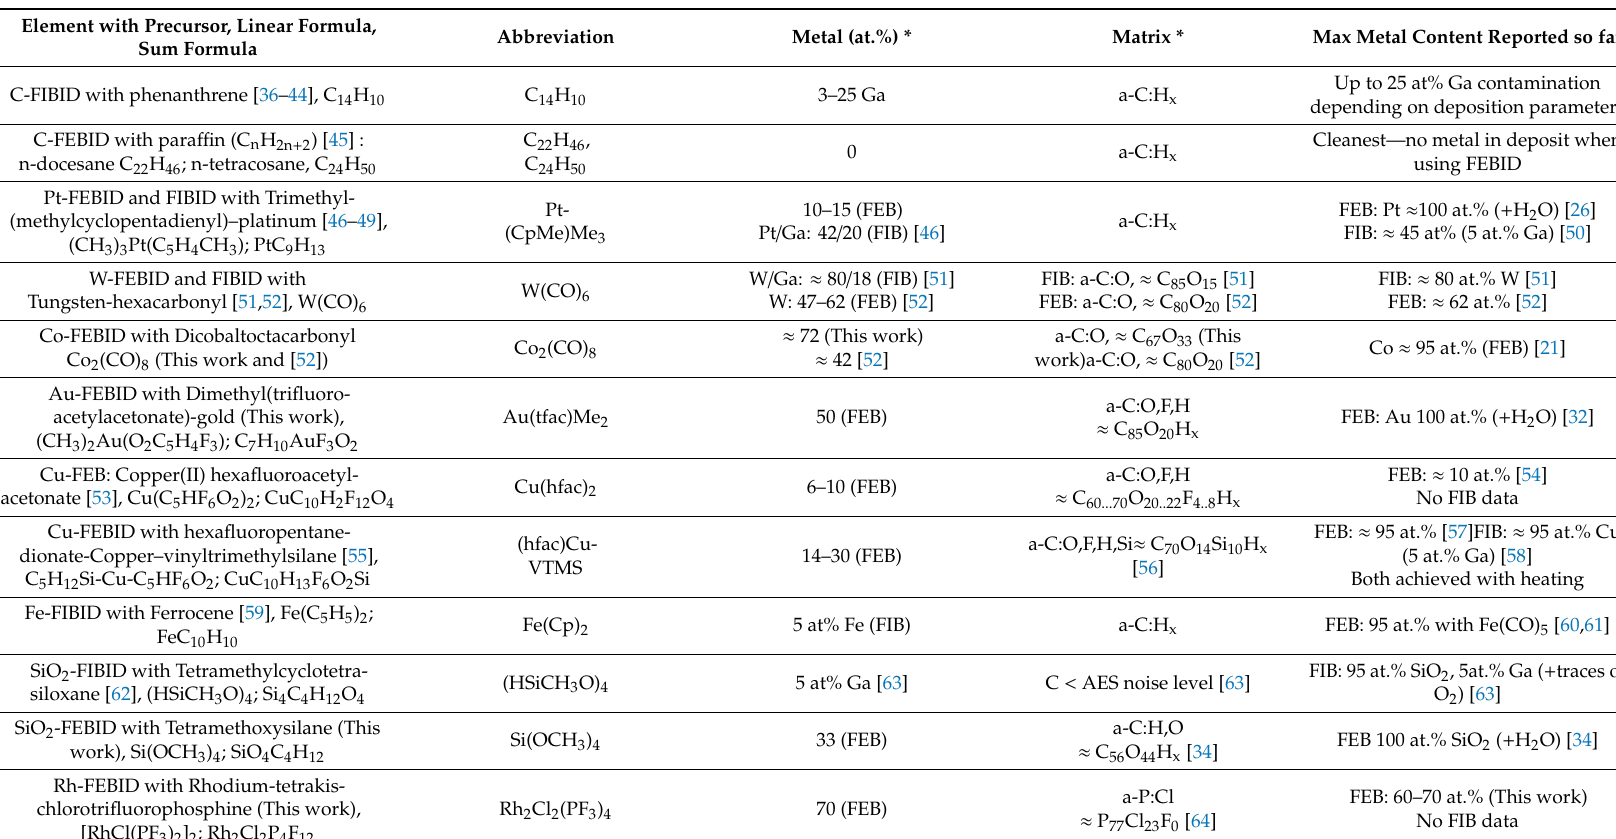
Table 1. Summary of precursors and references of focused electron beam and focused ion beam-induced deposition (FEBID and FIBID) materials for which mechanical properties were reported. Chemical formulae and abbreviations as used in this article are given as well as the resulting deposit metal content and matrix composition. The maximum achieved metal contents (sometimes with additional co-reactant gases) obtained so far are shown in comparison with the corresponding reference.